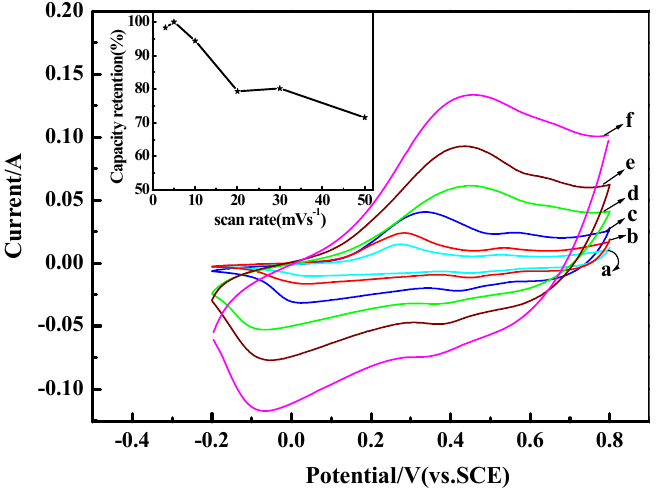
Figure 7. Cyclic voltammetry curves of PANI-0.5 at different scan rates: ( a ) 3 mV . s − 1 ; ( b ) 5mV . s − 1 ; ( c ) 10 mV . s − 1 ; ( d ) 20 mV . s − 1 ; ( e ) 30 mV . s − 1 ; ( f ) 50 mV . s − 1 . The electrolyte is 1 M H SO ; the inset shows the capacity retention as a function of scan 2 4